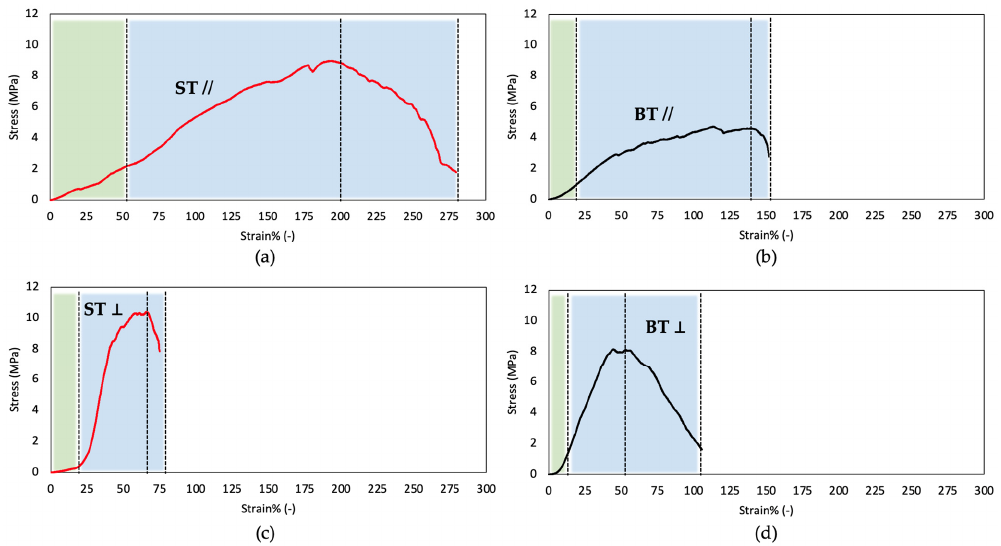
Figure 8. Representative stress–strain curves of ST ( a , c ) and BT ( b , d ) skin. Plots a and b were ob- tained in longitudinal direction, c and d in the transverse direction. Table 4. Mechanical properties of ST and BT. Results are expressed as mean value ± SD.